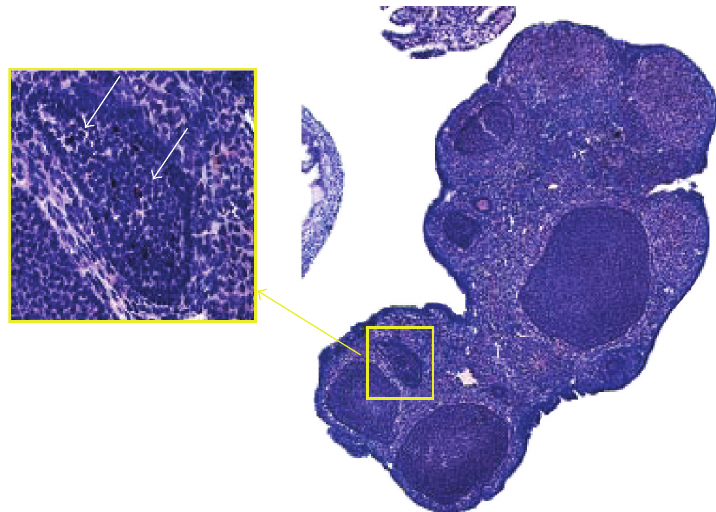
Figure 4: Apoptosis in the ovarian follicle . Mouse atretic follicles are known to undergo caspase mediated apoptosis. As anticipated, caspase 3 was cleaved and activated in the atretic follicle, which were used as positive control for the caspase 3 antibody specificity. Representative data from three separate experiments are